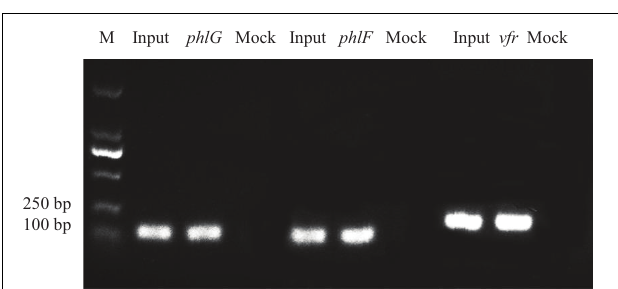
FIGURE 2 | Chromatin immunoprecipitation polymerase chain reaction assays. Three specific bands representing putative Vfr binding sequences for phlG , phlF and vfr were amplified from the immunoprecipitated chromatin DNA sample. Input = sonicated DNA fragments ranging from 100 to 500 bp in size; Sample = (cid:49) vfr/pBBR-vfr-3FLAG chromatin DNA immunoprecipitated with the anti-FLAG antibody; Mock = vfr/pBBR-3FLAG chromatin DNA immunoprecipitated with the anti-FLAG antibody (negative